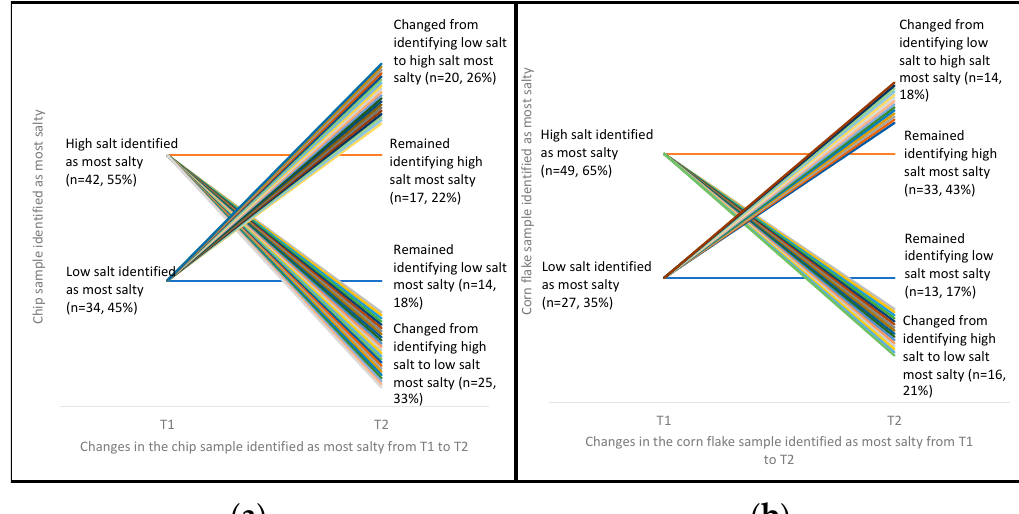
Figure 3. Participants’ identification of high salt potato chip ( a ) and cornflake ( b ) samples at T1 and T2 1,2,3,4 ; 1 Chip McNemar’s Test, p = 0.55; 2 Cornflake McNemar’s Test, p > 0.99; 3 ”Low salt” group includes both low and mid salt samples; 4 The ‘change’ lines are a visual representation of the number of children who changed which sample they ranked as most salty from T1 to T2—each color is a different child. As the graph is showing the changes in ARS over time, the ‘remain’ lines stay the same thickness at both times points—this thickness does not represent the proportion of children who remained identifying the same sample as the most